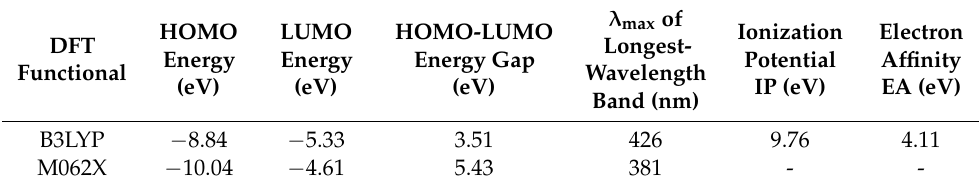
Table 4. Calculated values of frontier–orbital energies and corresponding absorption of the longest- wavelength band of the 7-tetradecyl BPDTQ + cation in methanol, together with its ionization potential IP and electron affinity EA.